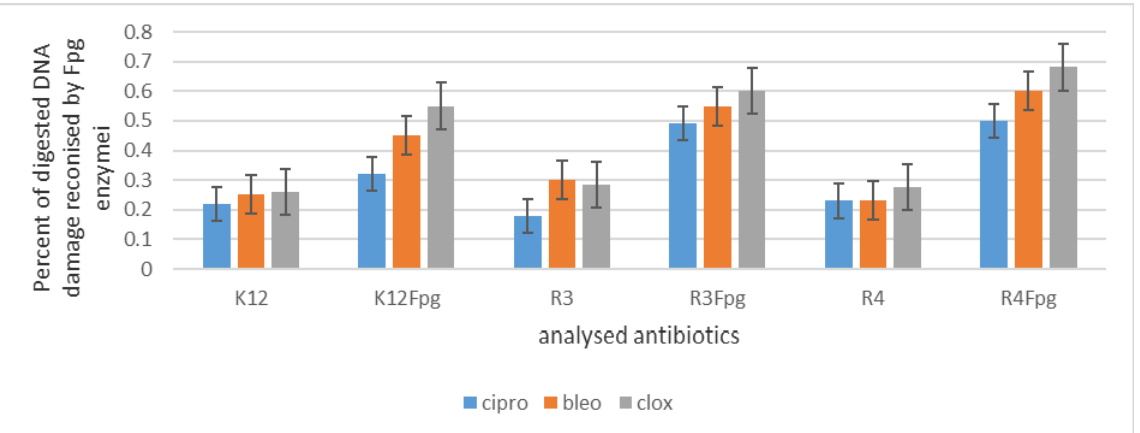
Figure 11. Percentage of bacterial DNA recognized by Fpg enzyme in model bacterial strains after ciprofloxacin, bleomycin, and cloxacillin treatment. The compounds were statistically significant at p < 0.05 (Supplementary Materials Figure S3).